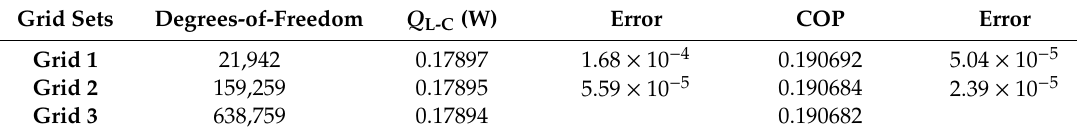
Table 3. Grid independence test with element allocation ( m 1 = m 2 = n 1 = n 2 = 10).